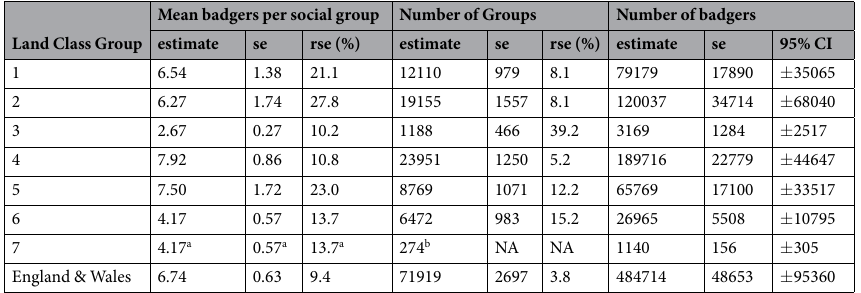
Table 2. The estimated number of badgers in each Land Class Group as calculated from the estimated mean number of badgers per social group and number of social groups and extrapolated population estimates for England and Wales combined (with standard errors, relative standard errors and 95% confidence intervals shown as appropriate). a Assumed to be equal to LCG 6, b based on the observed number of other setts and the assumption that there is approximately one main sett for every four “other” setts in LCG7.